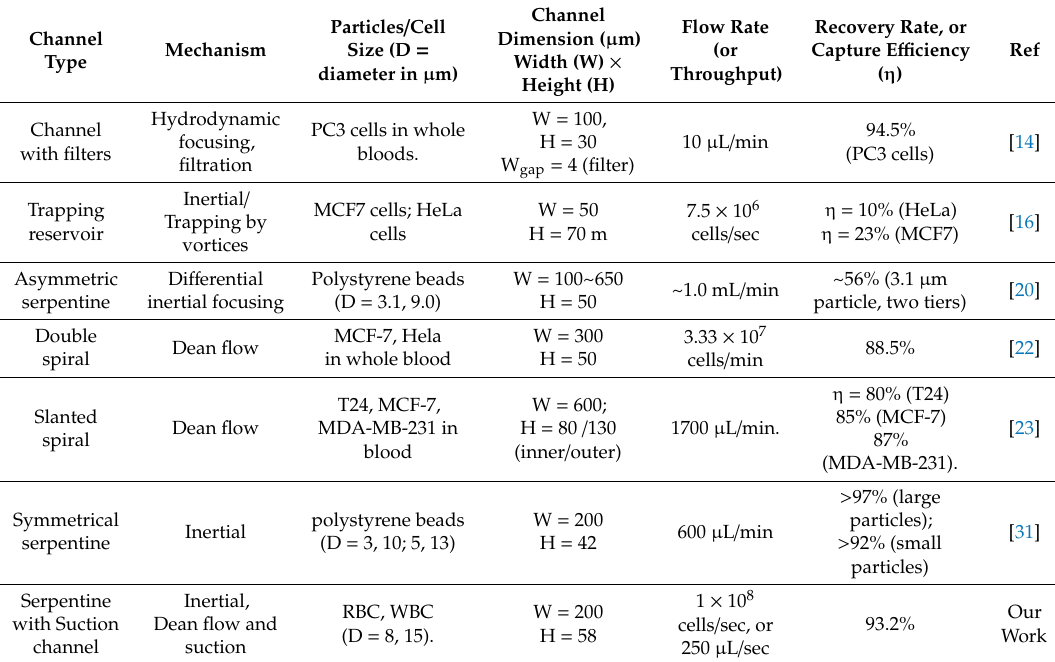
Table 2. Comparison of some existing microfluidic techniques for particle / cell